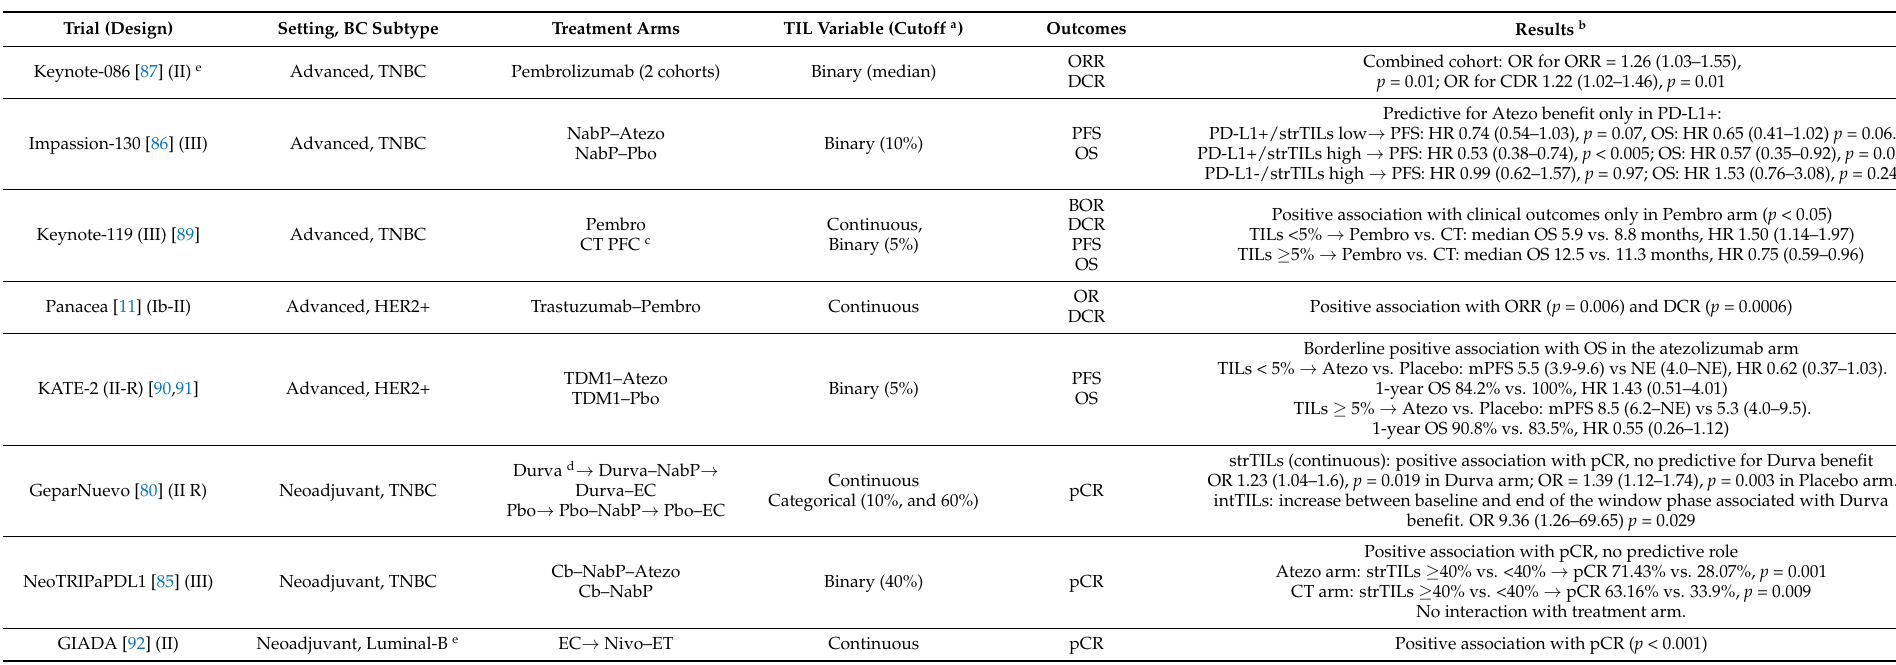
Table 2. Summary of phase II/III clinical trials investigating immunotherapy in BC with results from TIL analysis